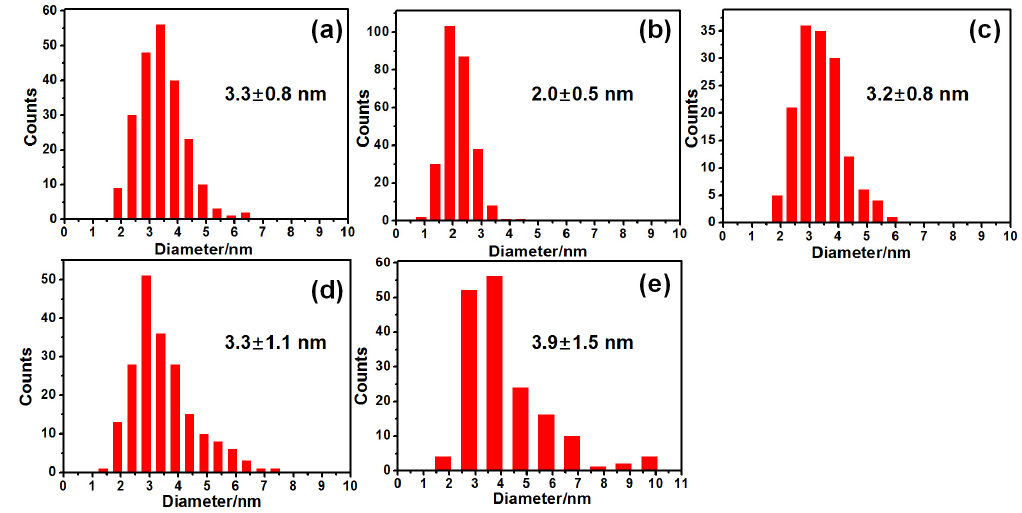
Figure 4. Au particle size distributions of ( a ) Au/ZnO, ( b ) Au/Zn 0.7 Fe 0.3 O x , ( c ) Au/Zn 0.5 Fe 0.5 O x , ( d ) Au/Zn 0.3 Fe 0.7 O x , and ( e ) Au/Fe 2 O 3 .